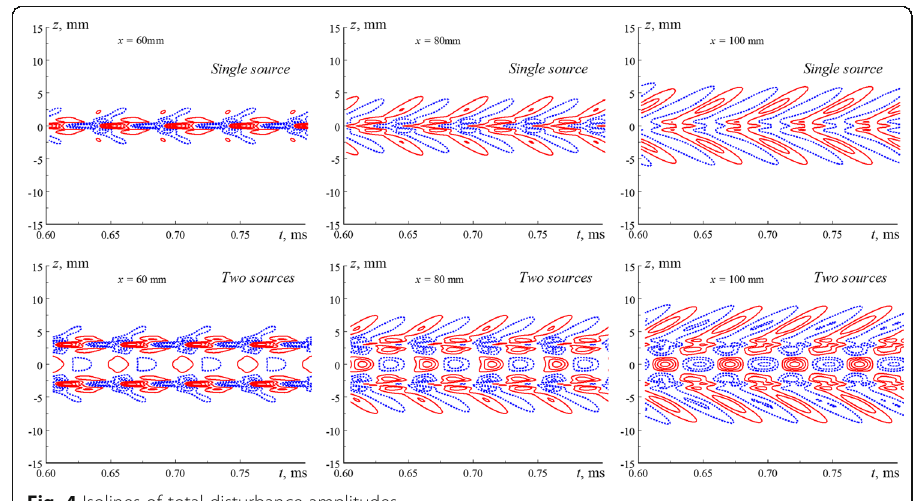
Fig. 4 Isolines of total disturbance amplitudes